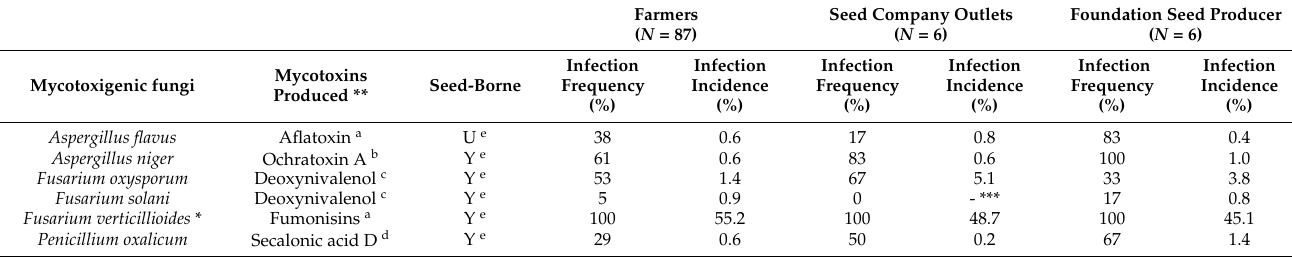
Table 1. Overview of mycotoxigenic fungi identified in maize seed samples obtained from farmers ( N = 87), a seed company outlet ( N = 6), and a foundation seed producer ( N = 6). Samples were collected in 2009 and 2010 in Nigeria. Fungal growth in each sample was determined for 500 undamaged, surface sterilized seeds after 4 days of incubation on agar. The infection frequency, i.e., the percentage samples with at least one infected seed, and the median infection incidence, i.e., the median of the percentage of seeds infected per sample based on infected samples only, are shown for seed samples from farmers, a seed company, and a foundation seed